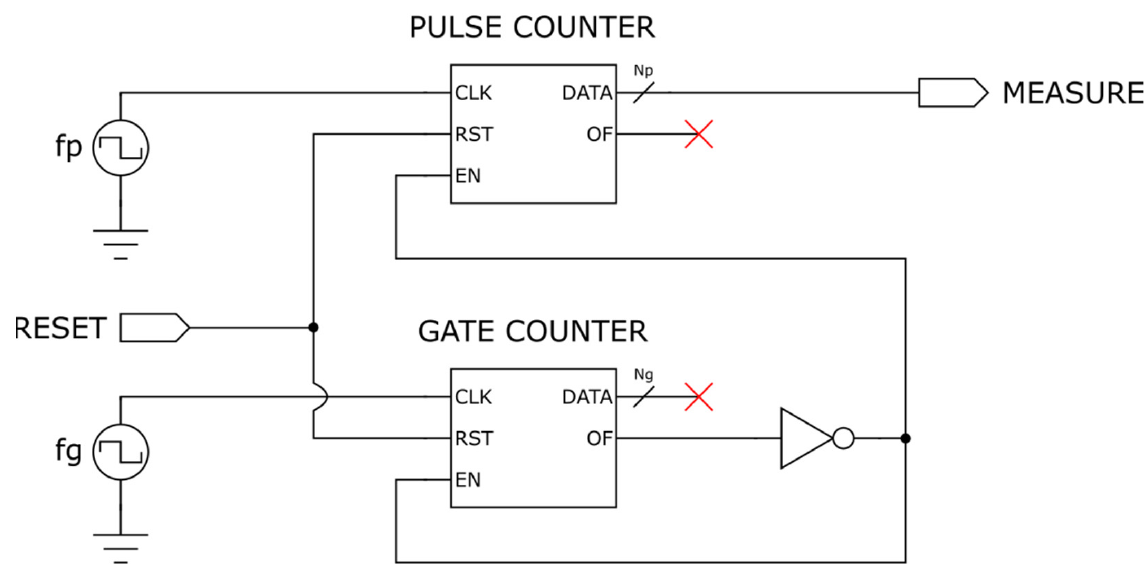
Figure 2. Generic structure of a frequency counter.